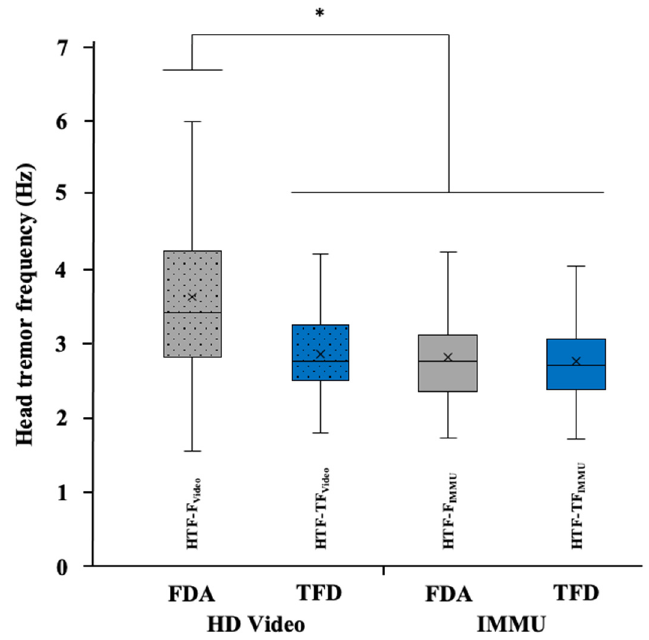
Figure 5. Box plots of the head tremor frequency obtained from the video and IMMU data using frequency domain analysis (FDA) and time-frequency domain analysis (TFD). In each box, the center line and the cross represent the median and the mean value, respectively; the top and bottom of the box correspond to the 25th and 75th percentiles; and the whiskers represent the 10th and 90th percentiles. Note: * indicates a significant difference ( p < 0.05). Table 2. Summary of the Spearman rank correlation analysis between head tremor severity (TOT- HEADTREM) and log-transformed values of linear and angular amplitude of head tremor.